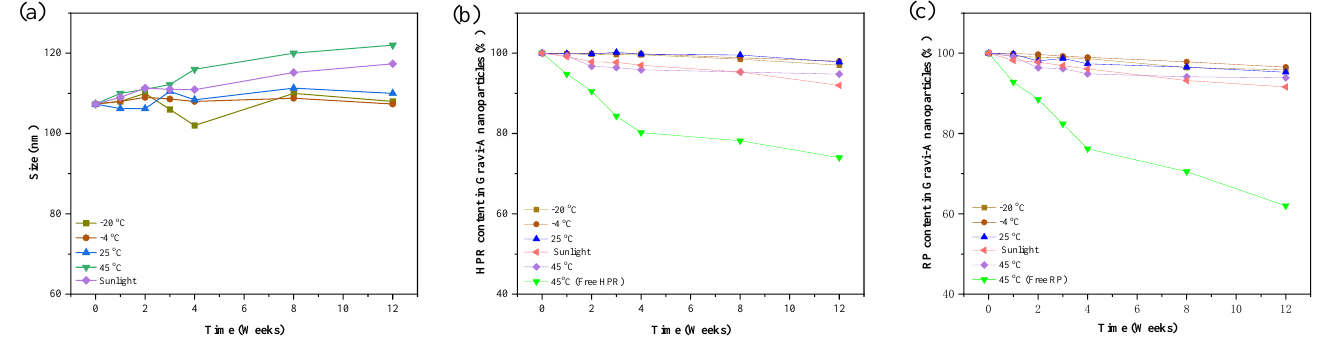
Figure 2. ( a ) Particle size stability. Content stability of ( b ) HPR and ( c ) RP in Gravi − A nanoparticles subjected to different temperatures or periods.